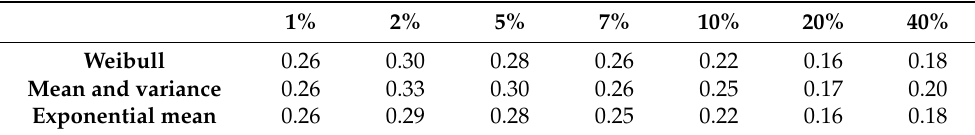
Table 12. Main statistics of the discharge vector Weibull and exponential